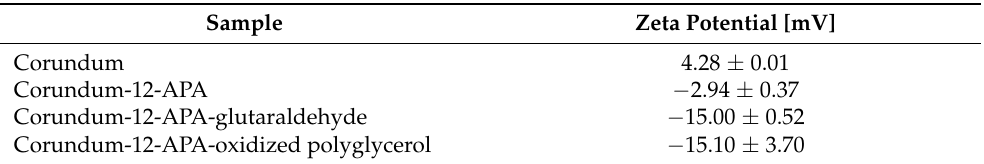
Table 1. Zeta potential measurements of unfunctionalized and functionalized corundum. Meas- urements were performed in 1 mM KCl at a pH of 7.